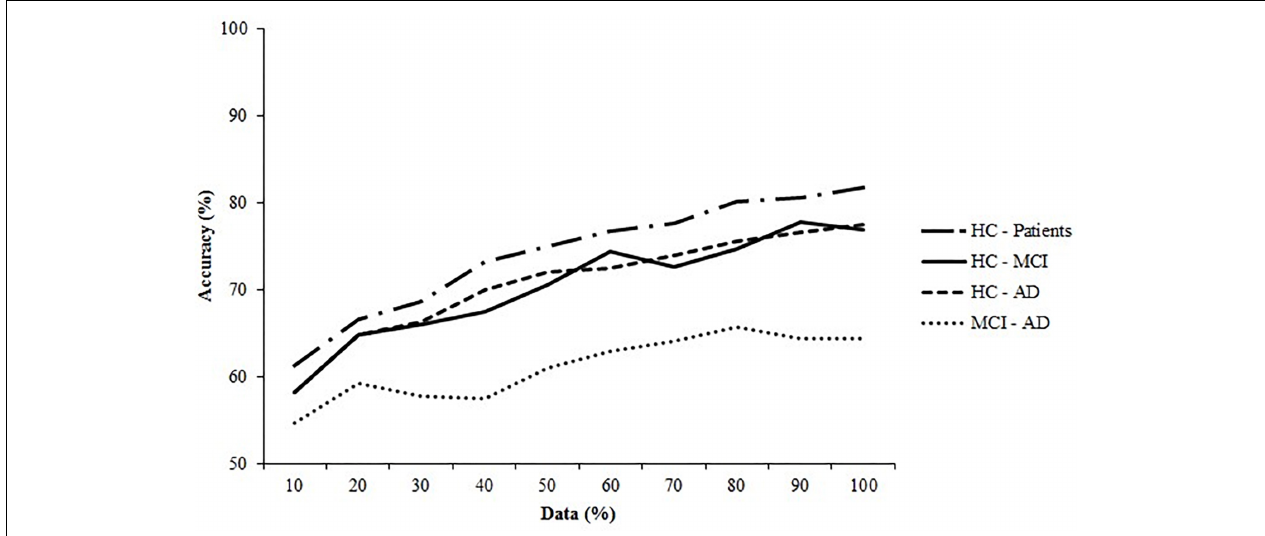
FIGURE 6 | Learning curves for the healthy controls (HC) and the Alzheimer’s Disease (AD) patients and the Mild Cognitive Impairment (MCI) patients. The SVM (linear) for the HC—patients, HC—MCI, and HC—AD are plotted and of the ANN (6 neurons) the MCI—AD dataset is plotted.